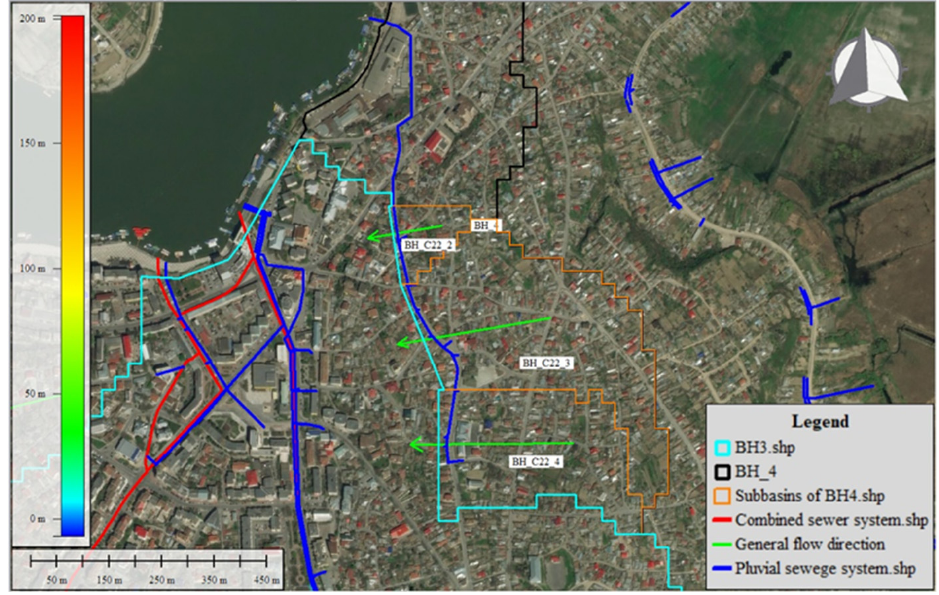
Figure 12. Detail of the flow direction in the eastern area of Tulcea city.